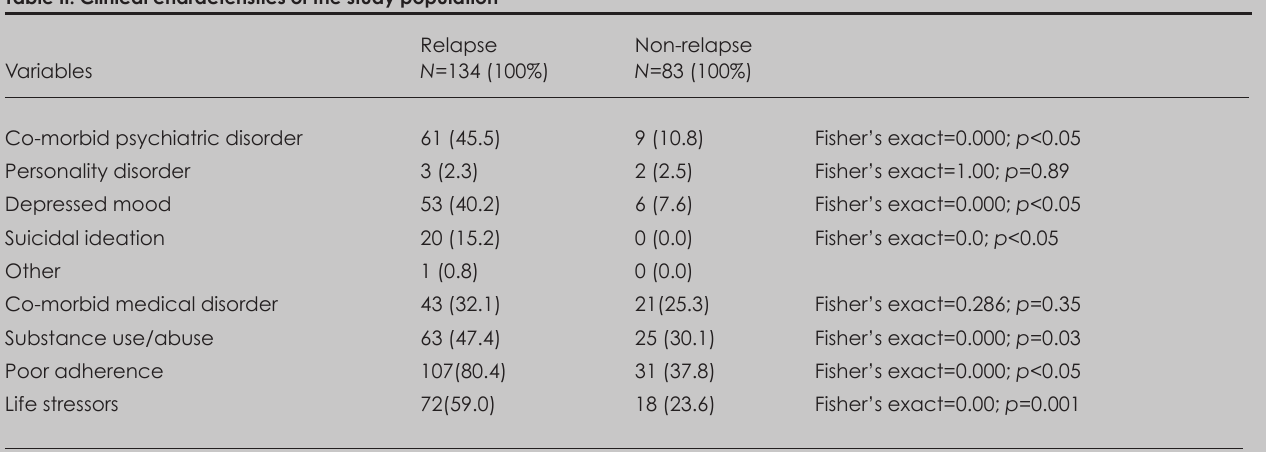
Table II. Clinical characteristics of the study